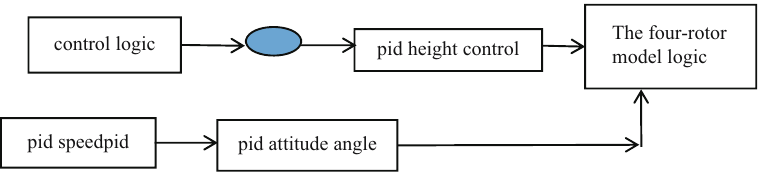
Figure 1: Quadrotor control structure